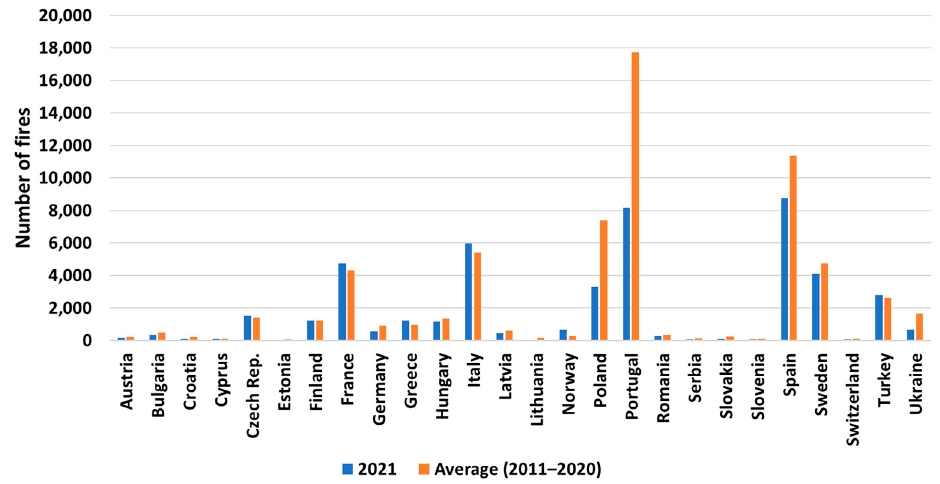
Figure 1. Number of fires in EU for 2021 and the average number of fires during the years 2011–2020.